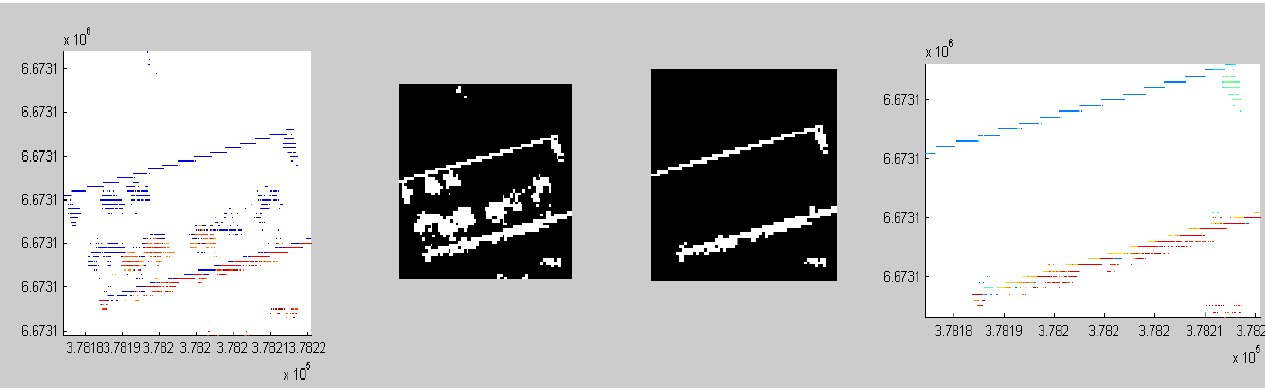
Figure 9. An example of the procedure of transformation of 3D point clouds into 2D binary images, non-building points filtering on images, then into 3D point